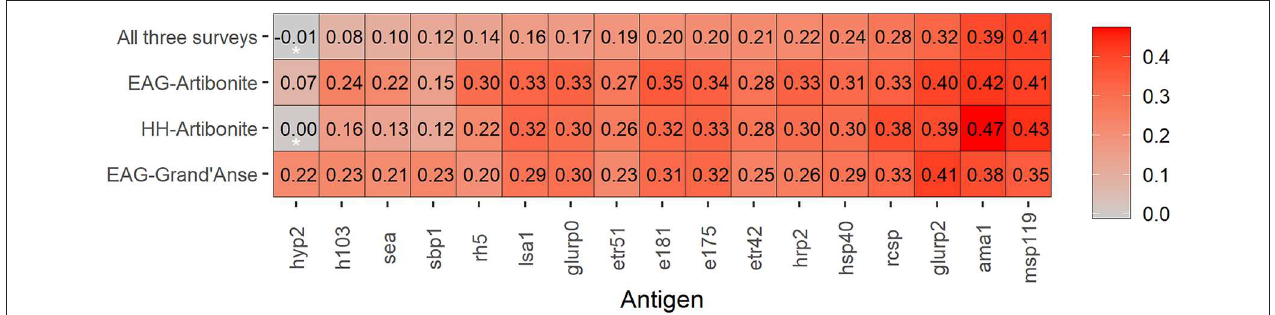
FIGURE 1 | Heat map of Spearman correlation coefficients for age and immunoglobulin G (IgG) responses to seventeen Plasmodium falciparum antigens across three malaria transmission surveys in Haiti. IgG responses were defined as log10-transformed median fluorescence intensities corrected for background reactivity, while age is in years. Data is shown for 28,888 participants; highly sensitive rapid diagnostic test (hsRDT) positives were excluded ( n = 536) to remove any IgG responses due to a current or recent infection. Coloring represents the strength of Spearman correlation coefficients from weak in grey to strong in red. Antigens (x-axis) are ordered from the lowest to highest Spearman correlation coefficient using data from all three surveys. Spearman correlation coefficients that were not statistically significant (i.e., p > 0.003 assuming Bonferroni correction for multiple testing) are indicated with an asterisk (*); all other age and IgG comparisons had p -values <